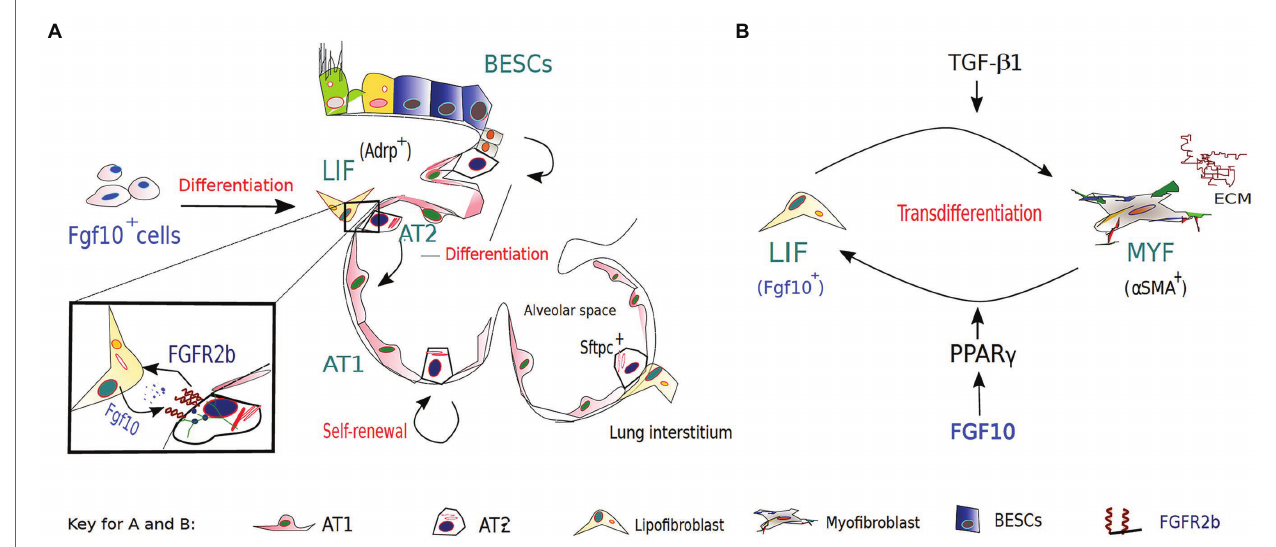
FIGURE 2 | The role of FGF10-FGFR2B signaling in lipofibroblast (LIF)-AT2 mediated alveolar repair and fibrosis development/resolution. (A) . During embryonic lung development, a subset of FGF10-expressing cells in the lung mesenchyme gives rise to LIFs, which are considered to be essential components of AT2 stem cell niches. AT2 cells and neighboring LIFs interact reciprocally via paracrine signaling pathways, such as the PPAR- γ pathway, in coordinating normal development, homeostasis, and regeneration/repair of the distal lung. Apart from other reserve stem cell populations for the alveolar epithelium, AT2 cells are important progenitors during repair after lung injury and during normal lung homeostasis. (B) The origins of activated myofibroblasts (MYF) in fibrotic lungs remain speculative; however, FGF10-expressing LIFs have been implicated as a novel source of the activated myofibroblasts. Following bleomycin-induced injury, lipofibroblasts are thought to transdifferentiate into activated myofibroblasts, from which a subpopulation reverts to a quiescent phenotype characteristic of the pre-existing LIFs during fibrosis